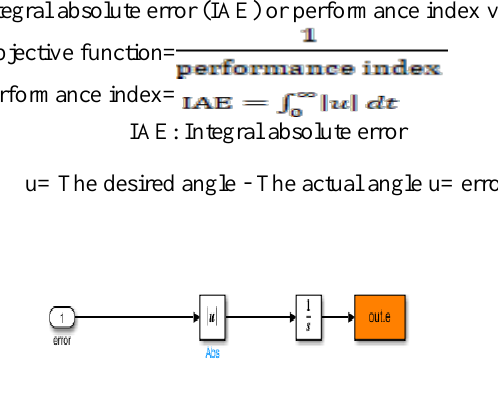
Figure 15. Fitness function for tuning PID